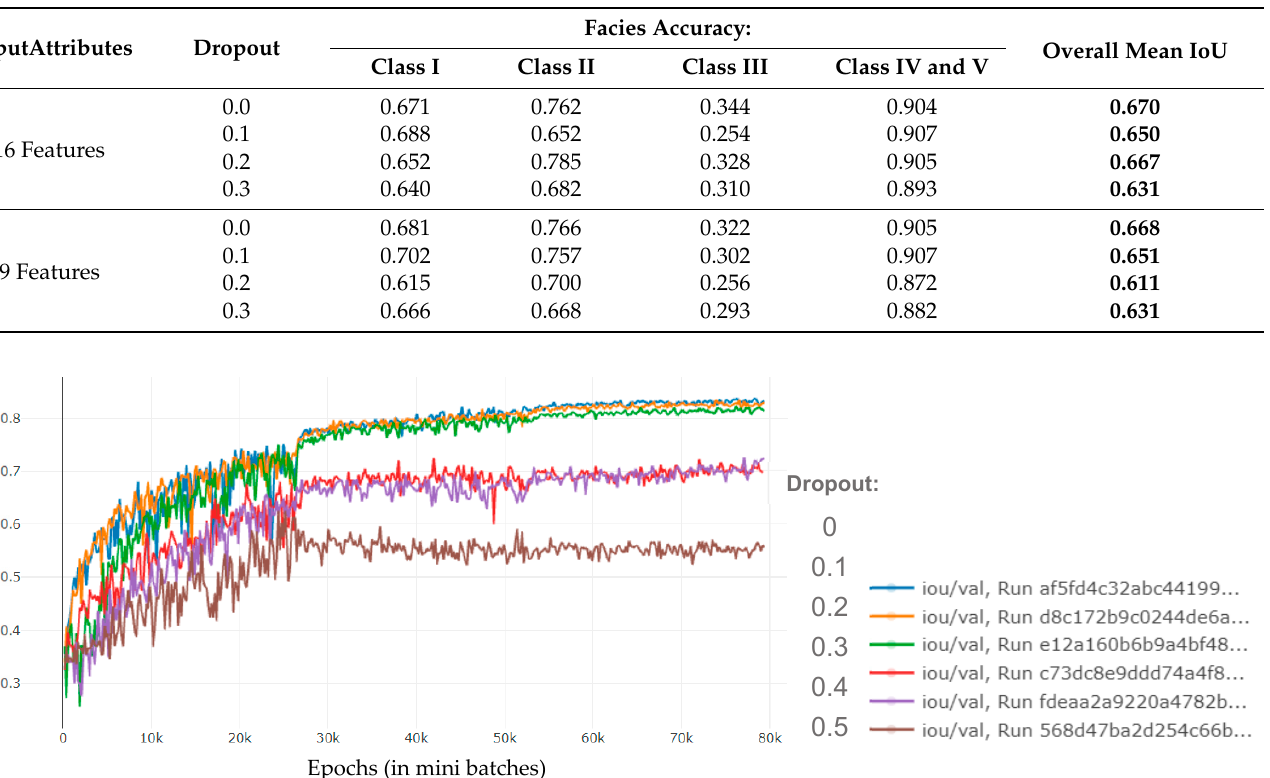
Figure 6. Performance plot represents different dropout values ranging from 0 to 0.5 during validation stages. All experiments show a similar progress pattern before reaching plateau phase due to the stochasticity of data augmentations.